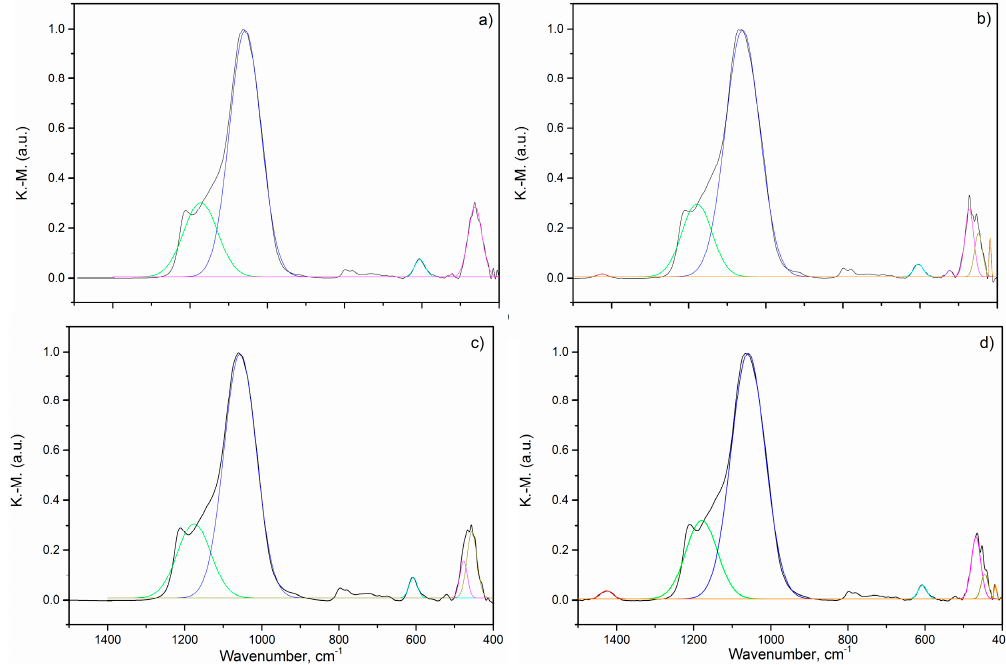
Figure 4. Deconvolution of spectral region between 1500 and 400 cm − 1 : ( a ) NZ; ( b ) NZA; ( c ) FeZ; and, ( d ) FeA.